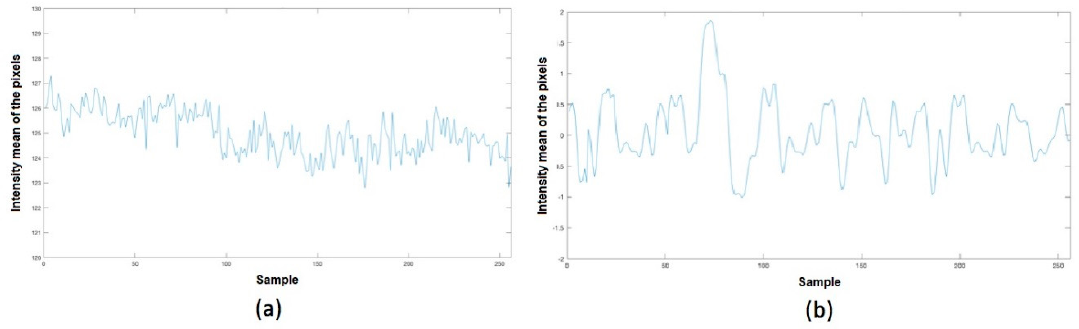
Figure 4. Comparison of the signals: ( a ) signal acquired in the first step of the algorithm; ( b ) signal with a passband filter of 0.5 Hz to 3.1 Hz applied.